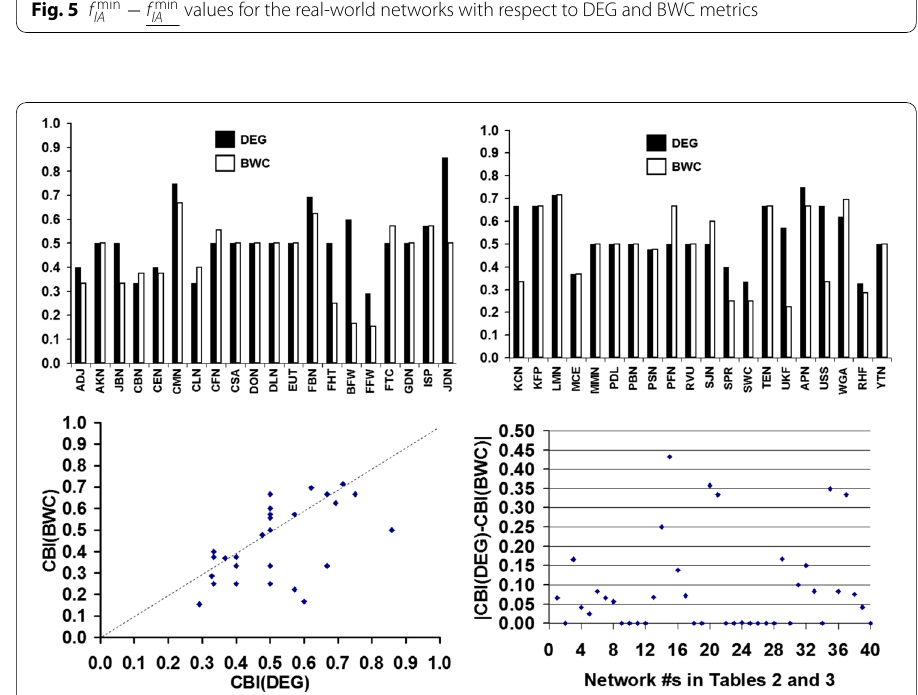
Fig. 6 Cascade Blocking Index (CBI) values for the real-world networks with respect to DEG and BWC